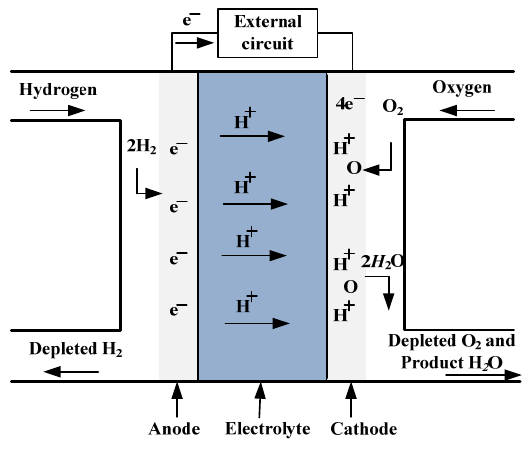
Figure 2. Schematic of an individual